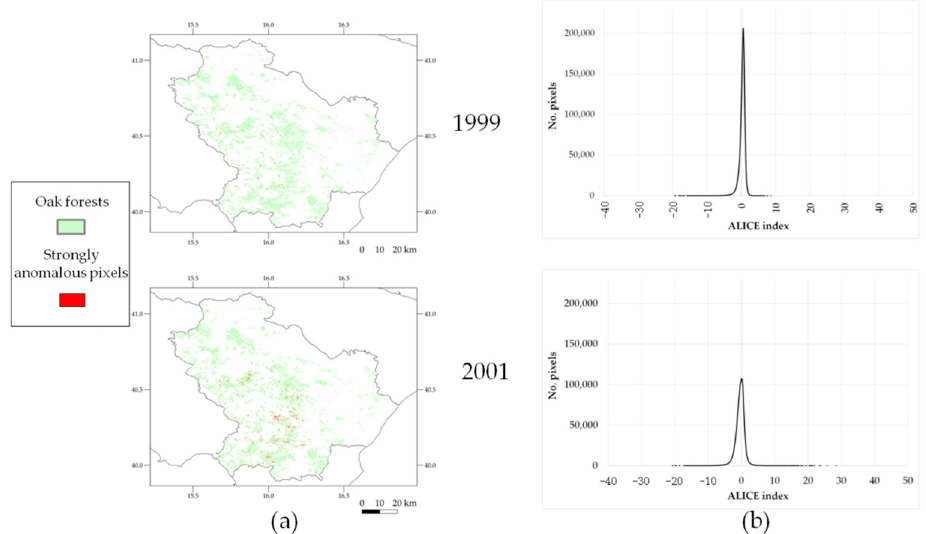
Figure 10. ( a ) Spatial distribution of the strongly anomalous pixels ( ⨂ NDVI_MVC ( x , y , t ′ ) ≤ − 3) through oak forests in Basilicata, showing the greater extension in 2001 as compared with 1999; ( b ) 1999 and 2011 histograms of the ALICE index distribution, highlighting the mode shift towards negative values.